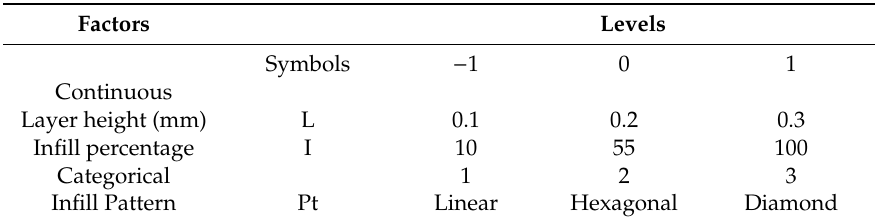
Table 2. Factors with their levels.